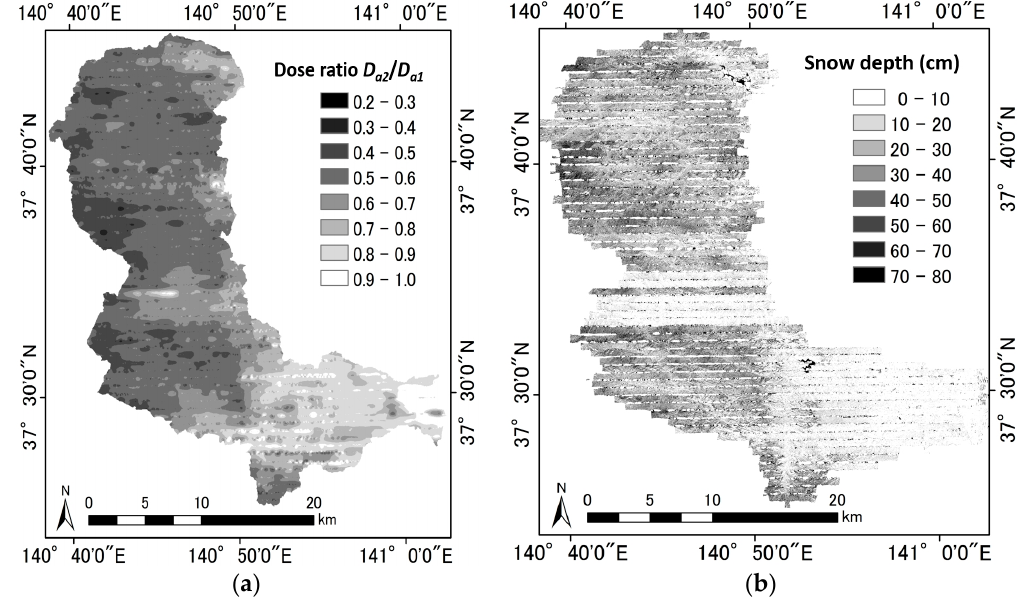
Figure 5. ( a ) Distribution of the ratio between the air dose rate before and after snowfall ( SF ); and ( b ) distribution of snow depth.